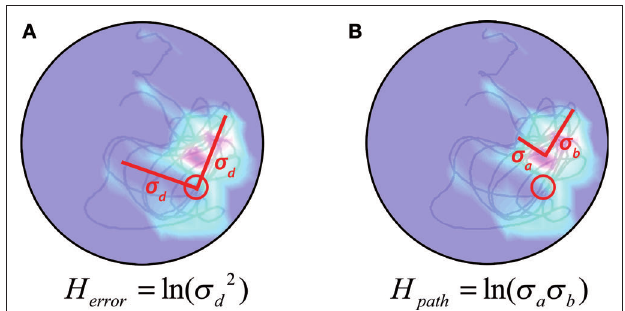
FIGURE 1 | The H measure. (A) The H component, centered on platform error location and varying in two dimensions by σ and σ . (B) The H component, d d path centered on the mean location of the animal’s trajectory and varying in two dimensions by σ and σ a b